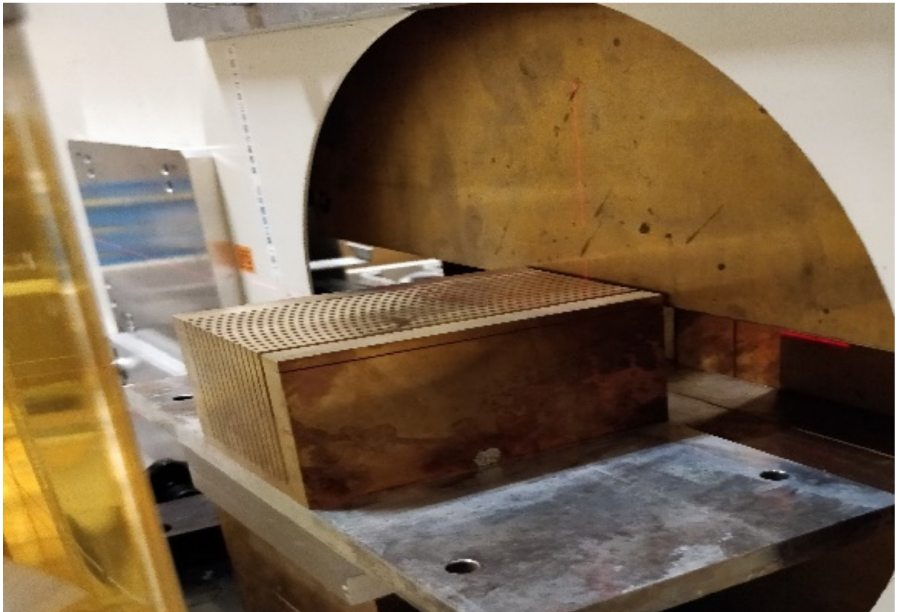
Figure 1. Photograph of the multislit brass collimator placed at the jaws exit of the beamline at biology room of HIMAC.